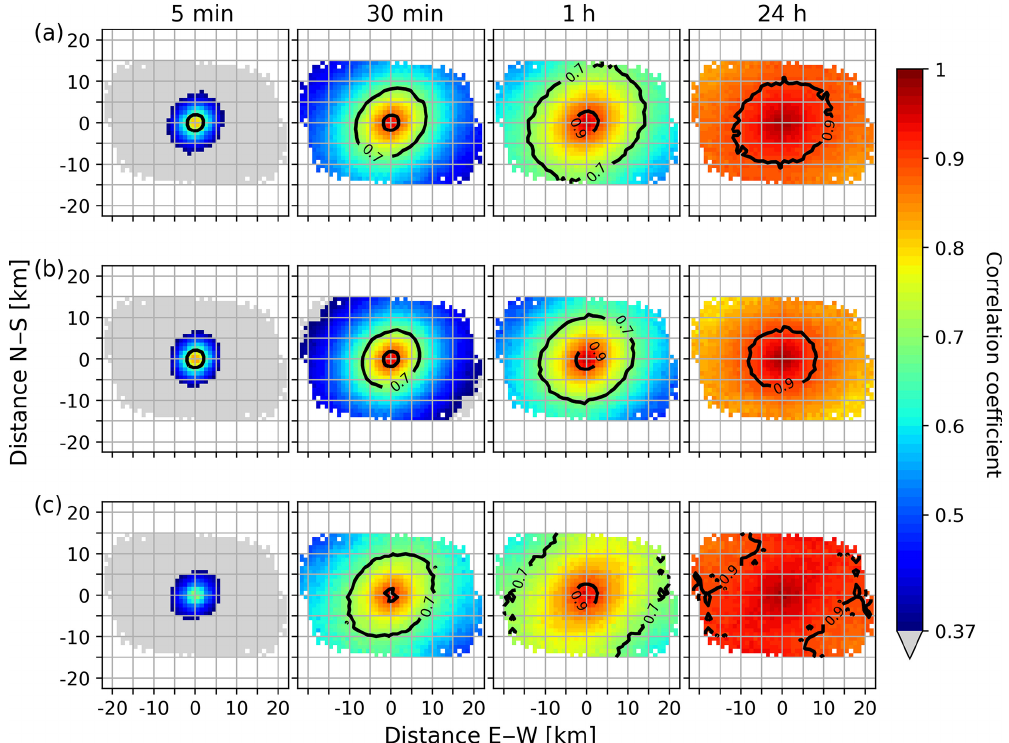
Figure 5. Same as Fig. 3 but for 10-year averaged spatial correlations in a two-dimensional space which is defined according to the distance between the gauges in east–west direction ( x axis) and north–south direction ( y axis). (a) All months, (b) warm season, and (c) cold season are shown. The values beyond the e-folding distance ( ≈ 0 . 37) are colored